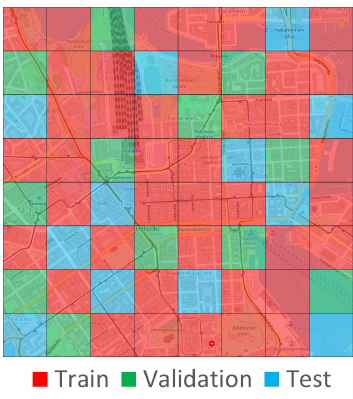
Figure 4. Tile distribution between